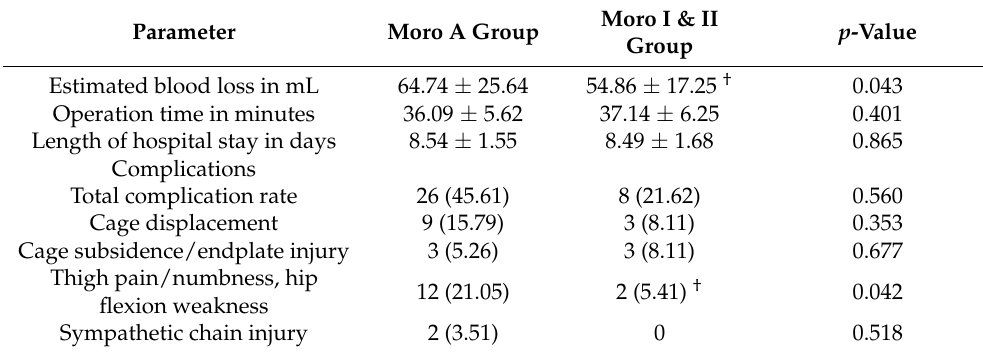
Table 2. Perioperative